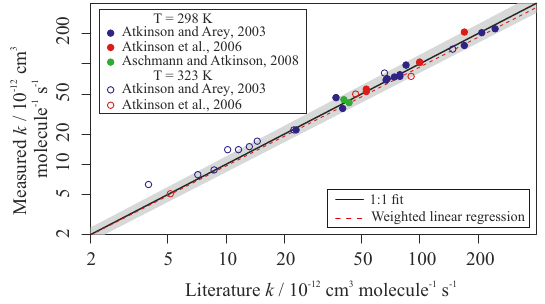
Figure 8. Measured VOC + OH rate coefficients plotted against lit- erature VOC + OH rate coefficients for all compounds measured as part of Mixtures 1, 2 and 3. Filled points represent data col- lected at room temperature (294 ( ± 2)K) and empty points represent data collected at the elevated temperature of 323 ( ± 10)K. The grey shaded area demonstrates a 25% uncertainty in the 1 : 1 gradient; most data fall well within this bound. Data lying outside this bound include 1-hexene at room temperature and 2,2,3-trimethylbutane and n -nonane at 323K. Weighted linear regression analysis for the data yields a slope with equation y = 1.00 ( ± 0.02) x + 0 . 96 ( ± 0.5) and an R 2 of